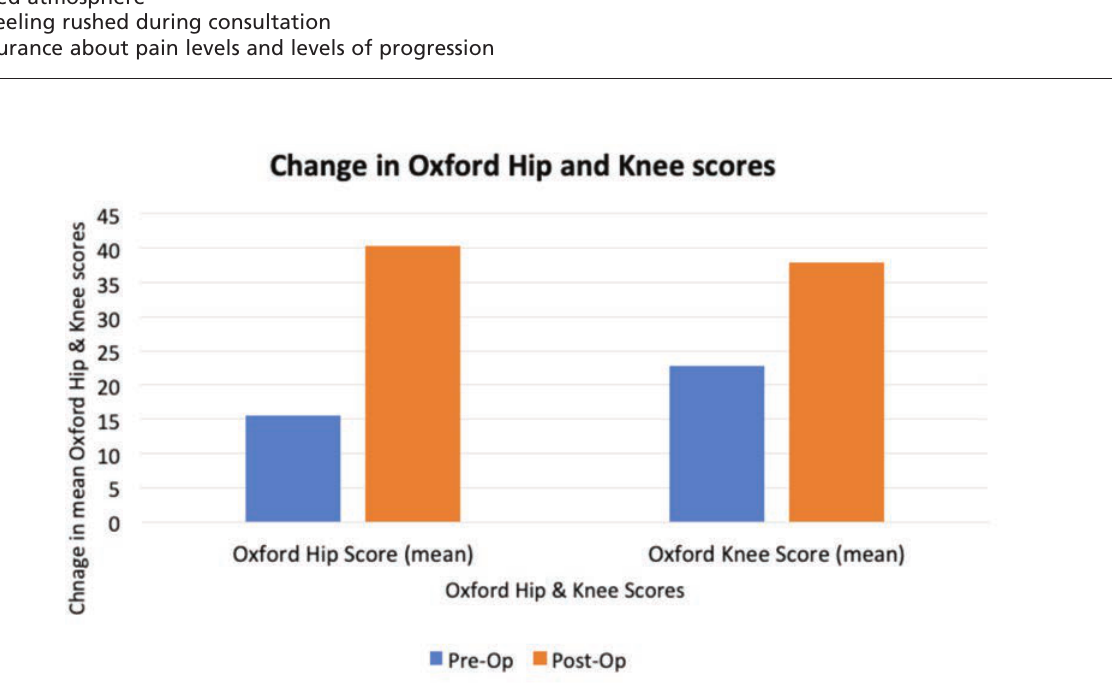
Mean Oxford hip and knee scores pre- and post-operative. Fig. 1: